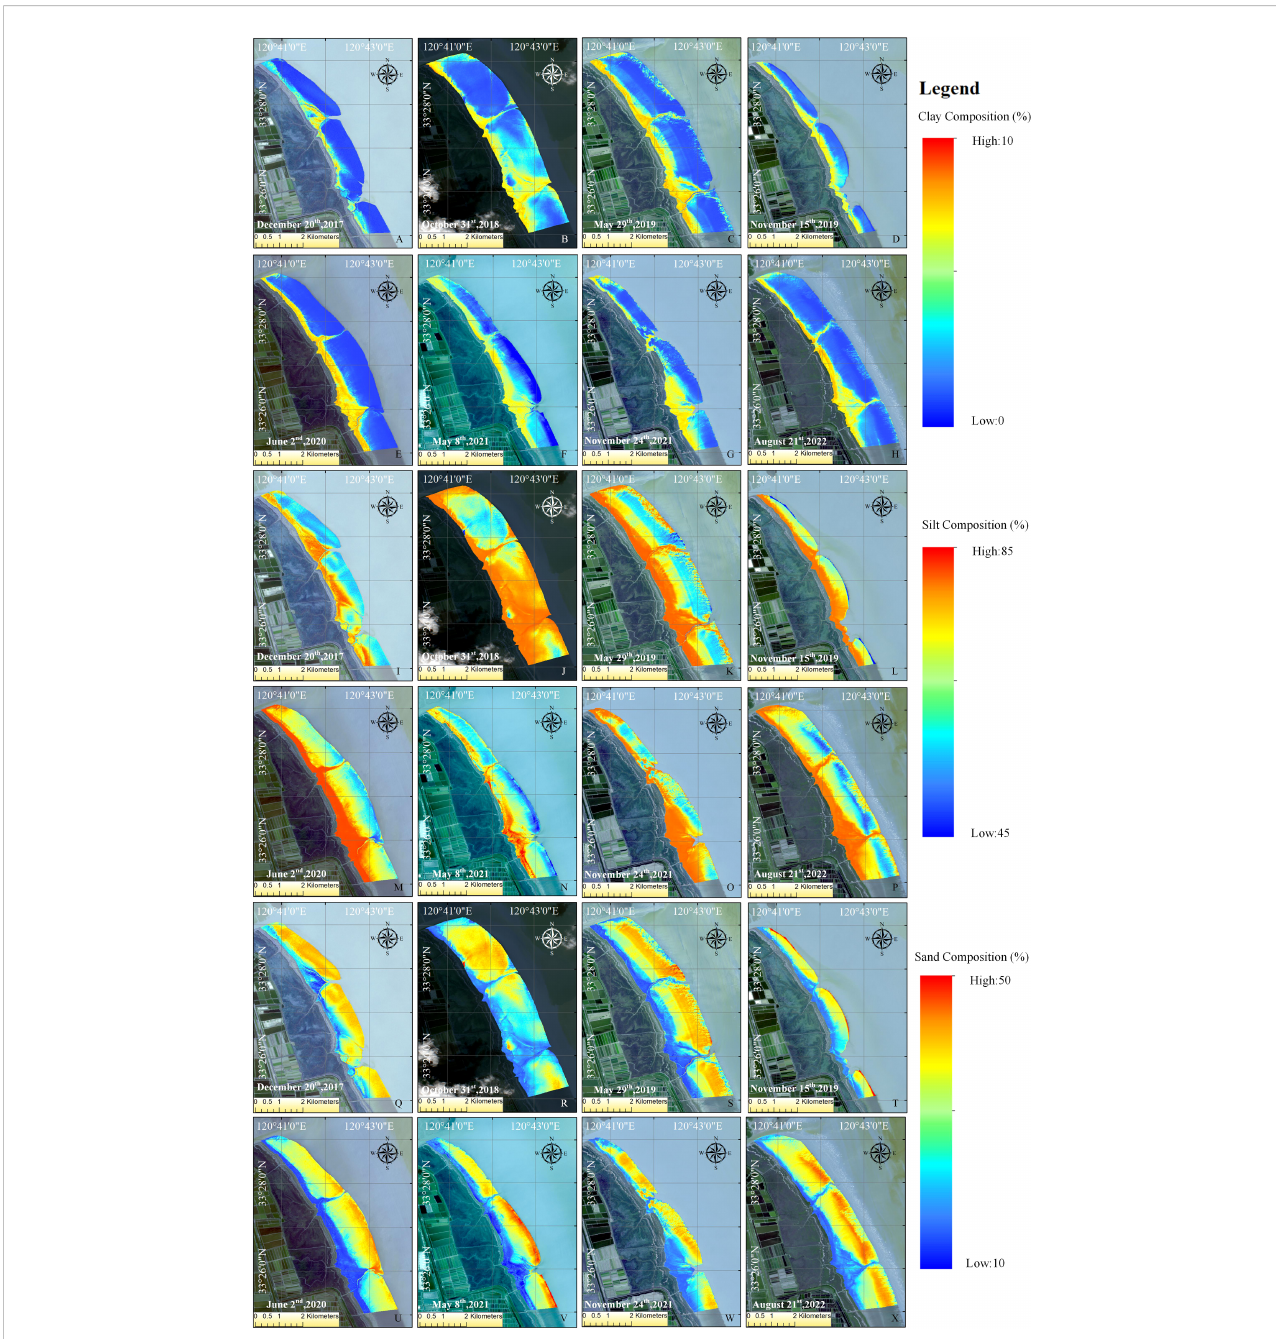
FIGURE 6 Inversion Diagram of the Sediment Component Contents in the Tidal Flat from 2017 to 2022 based on the BP-CNN Model Results. (A – H) , (I – P) , and (Q – X) , respectively show the spatial distribution of clay,silt and sand from 2017 to 2022. The sediment in the study area was mainly silty sand, followed by sand and then